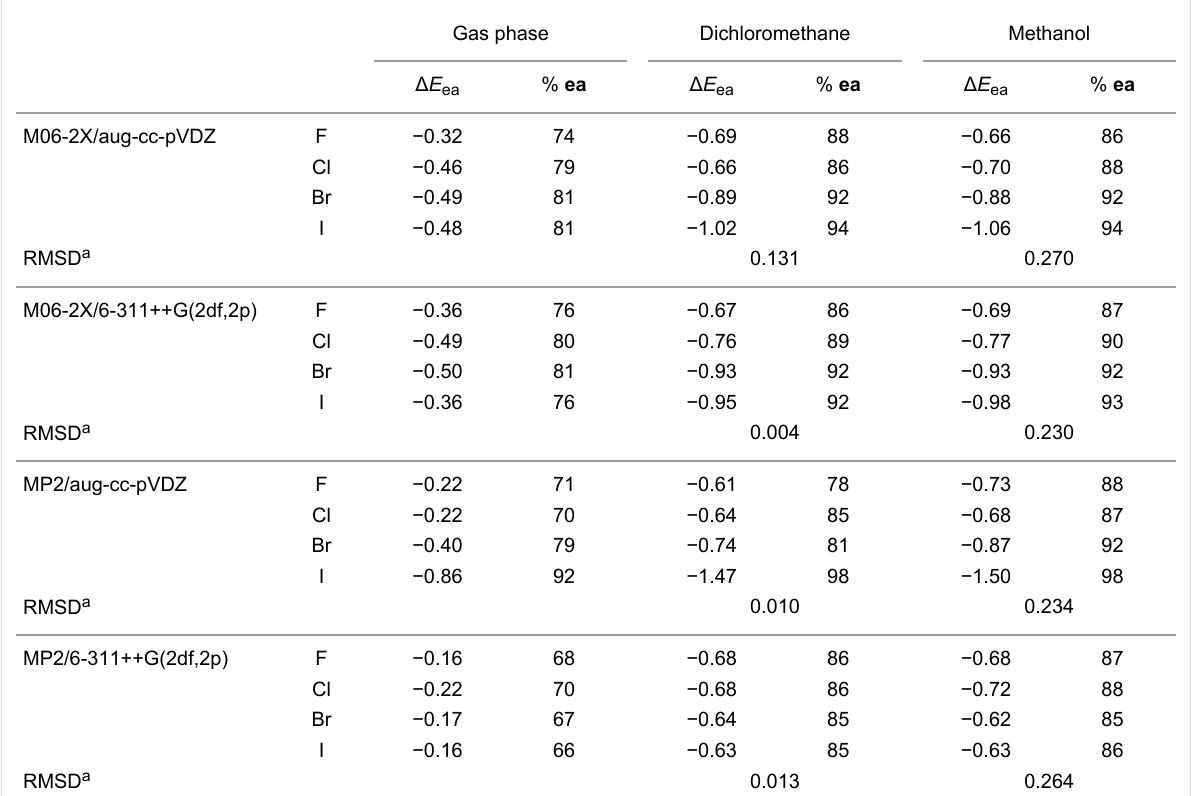
Table 3: Variation of conformational energy ( Δ E ea , kcal mol − 1 ) and populations of ea conformer determined theoretically in cis -2-halocyclohexyl-